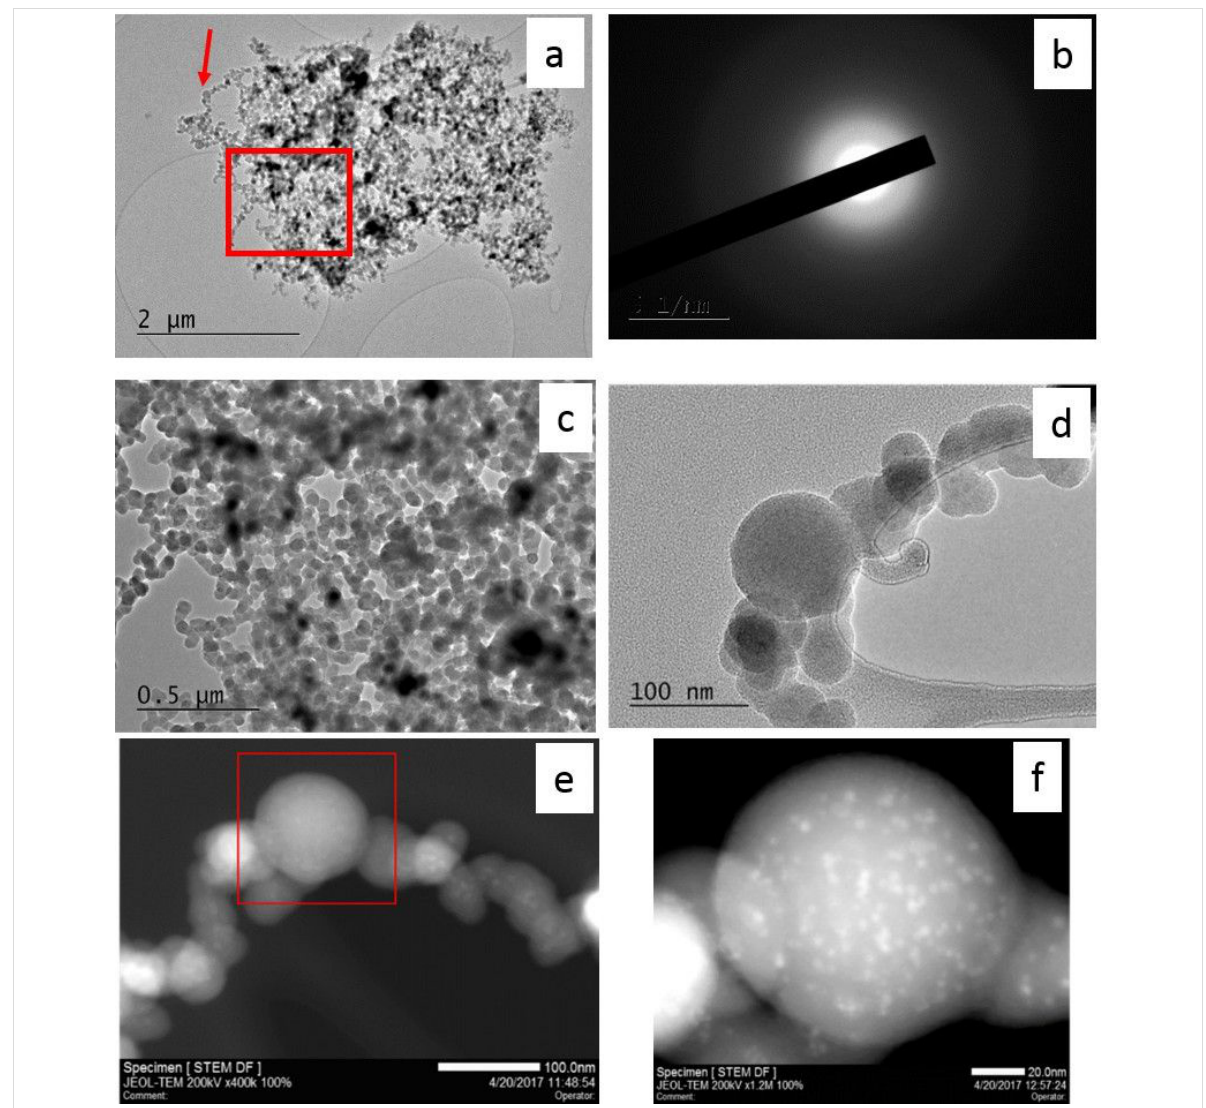
Figure 5: Sample B (SiO 2 +Ge, 165 mJ/pulse); a) TEM image of the same agglomerate/aggregate of nanoparticles of Figure 4a; b) diffraction pattern recorded for these nanoparticles; c) details of the zone inside the red square in panel a; d) details of the zone indicated by the red arrow in panel a; e) STEM image of the nanoparticles of panel d; f) STEM image of the largest nanoparticles of observed in the red square of panel